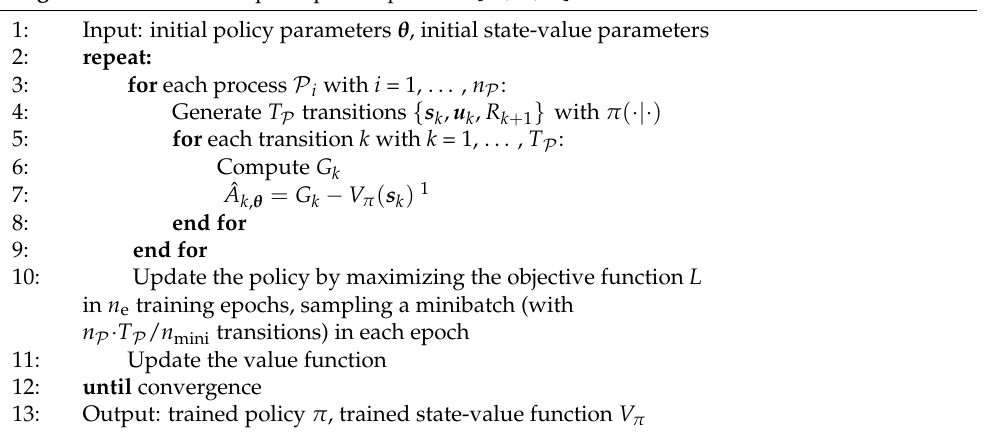
Algorithm 1. Basic PPO principle of operation